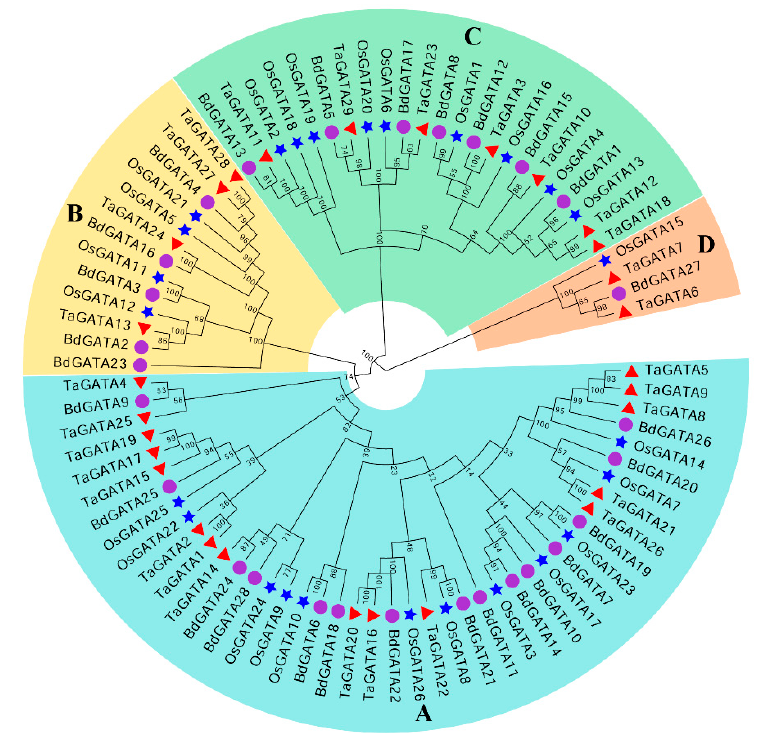
Figure 1. Phylogenetic tree of GATA proteins from Brachypodium distachyon , rice, and wheat. Phyloge- netic relationships of GATA proteins from Brachypodium distachyon (28), rice (26), and wheat (29) were performed with MEGA v5.0 using the NJ method with 1000 bootstrap replicates. The GATA proteins were clustered into four major groups—A, B, C, and D. Members of B. distachyon , rice, and wheat are represented by purple circles, blue stars, and red triangles, respectively. Gene IDs of GATAs from B. distachyon , rice and wheat were listed in Table S2.